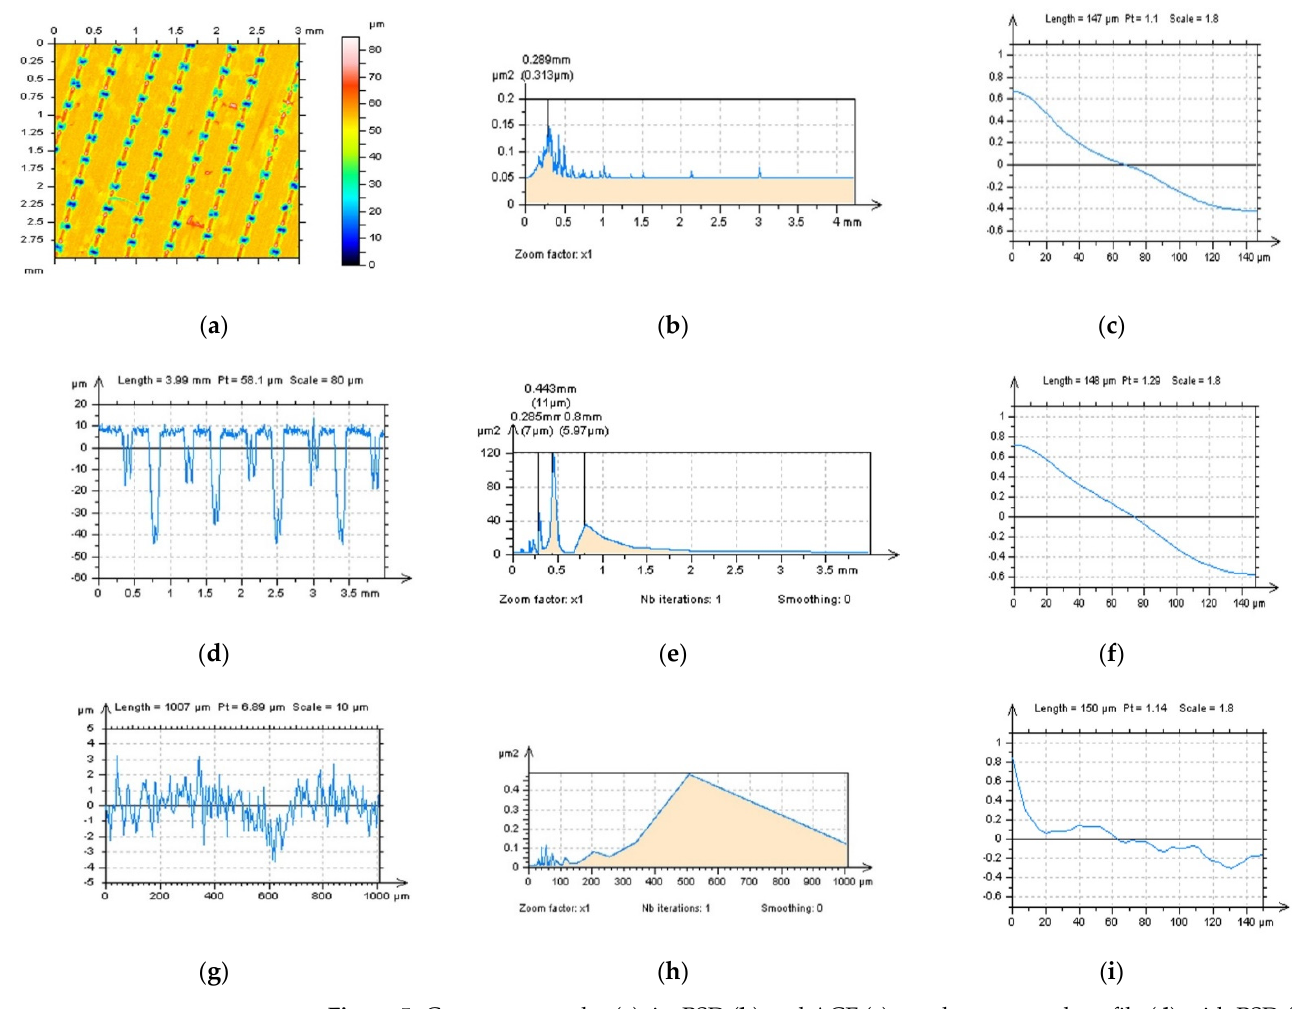
Figure 5. Contour map plot ( a ), its PSD ( b ) and ACF ( c ) graphs, extracted profile ( d ) with PSD ( e ) and ACF ( f ) graphs and, respectively, profile defined with a thresholding method ( g ) with PSD ( h ) and ACF ( i ) graphs, all defined for a laser ‐ textured